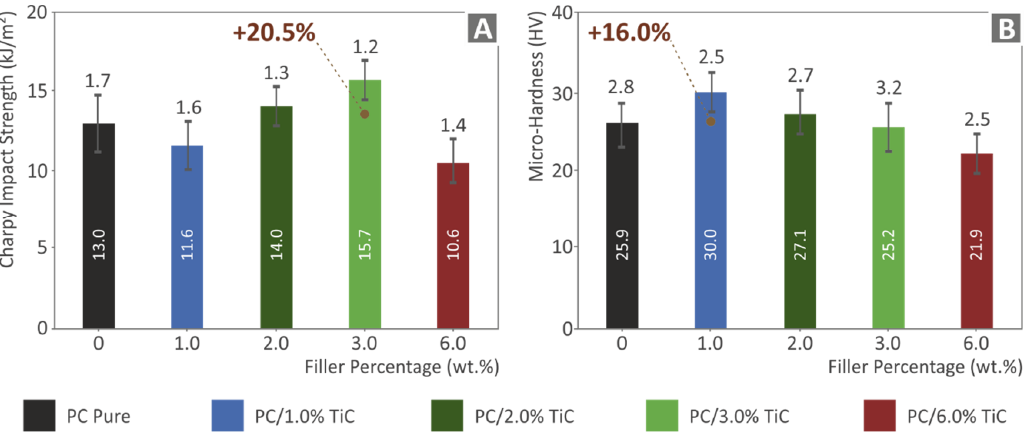
Figure 12. For all materials tested, results for: ( A ) impact strength (kJ/m 2 ); ( B ) microhardness.